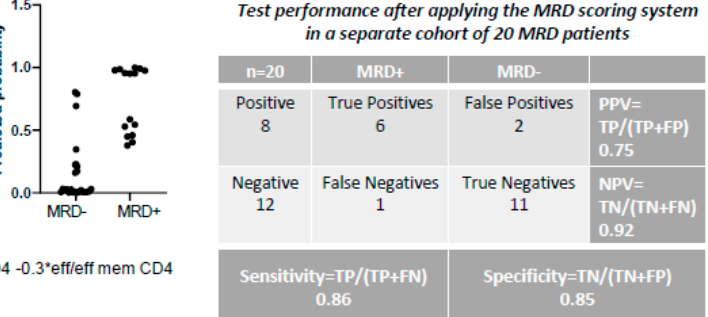
Figure 6. Peripheral blood (PB) profiling of MRD-positive (MRD + ) vs. MRD-negative (MRD − ) patients. ( A ) Relative frequencies of selected subpopulations according to MRD status; ( B ) PCA analysis including the whole immune pattern as input variables (left); PCA analysis including only selected subsets with significant di ff erences among MRD groups (right); ( C ) selection of naïve CD4 + and e ff ector / e ff ector memory CD4 + T cells allowed the prediction of MRD status with an AUC = 0.8; ( D ) MRD scoring system based on selected cut-o ff values for naïve CD4 + and e ff ector / e ff ector memory CD4 + T cells, tested on a di ff erent patient cohort ( n = 20). The negative predictive value (NPV) of the scoring system was improved to 0.92. * p < 0.05; AUC: area under the curve; TP: true positive; TN: true negative; FP: false positive; FN: false negative; PPV: positive predictive value; NPV: negative predictive value.